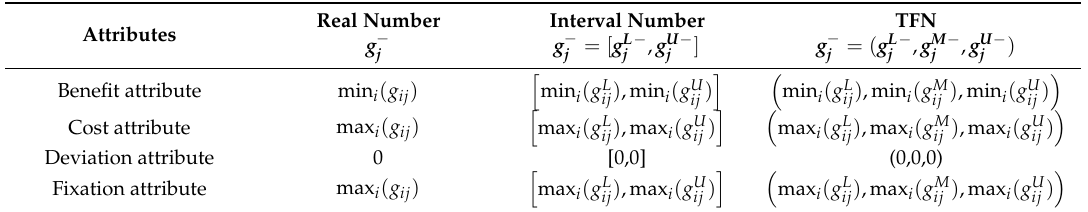
Table 2. Determination of negative ideal solutions (NISs) for heterogeneous attributes in different mathematical